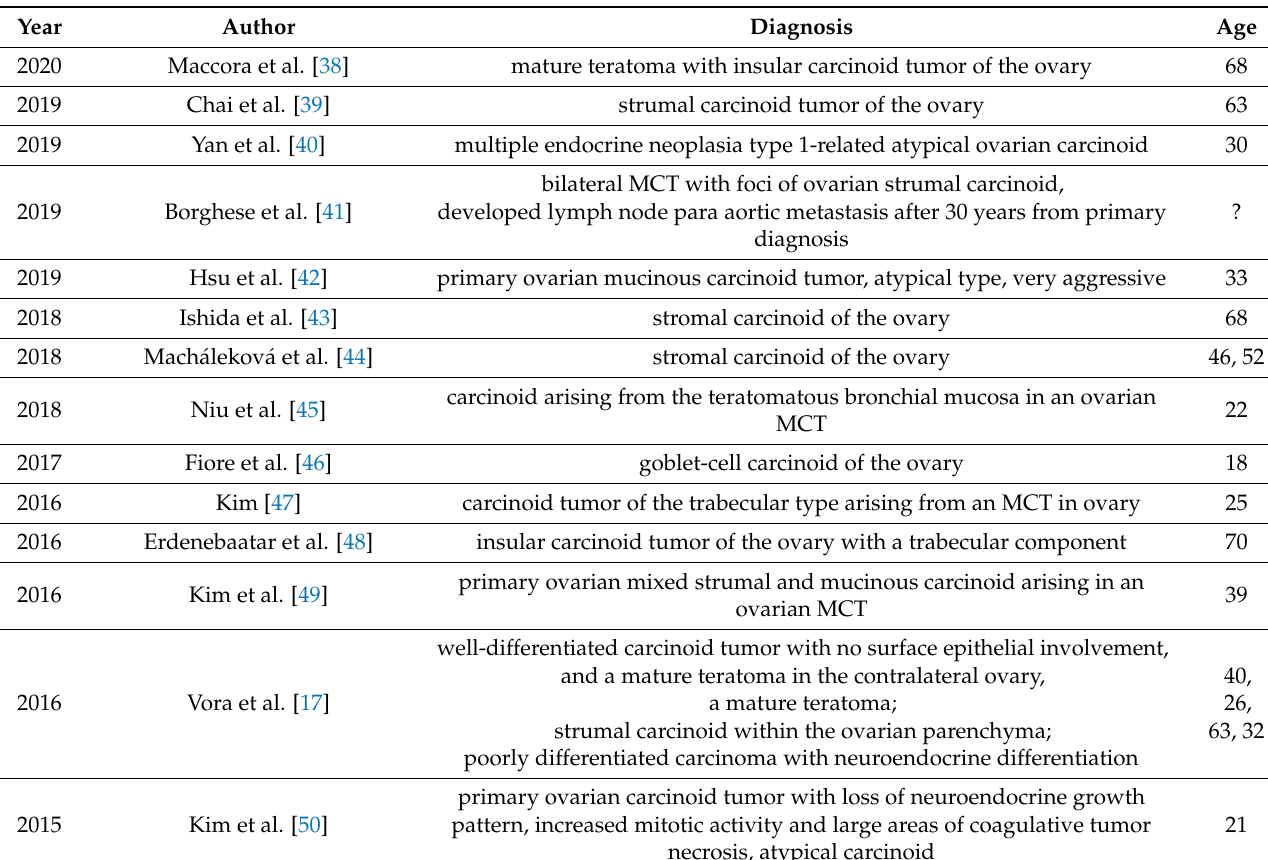
Table 2. Age of patients described in case reports of